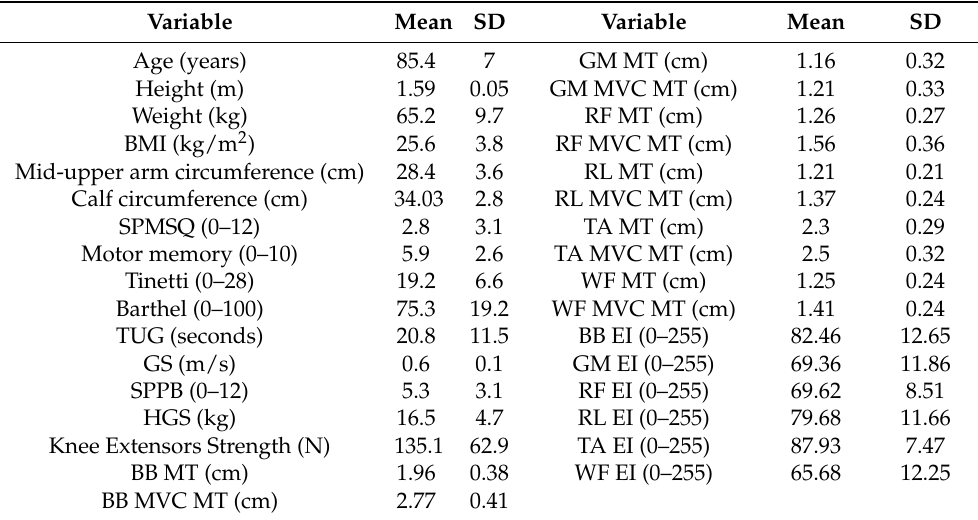
Table 1. Anthropometric, cognitive, physical functional, and ultrasonography characteristics. Variable Mean SD